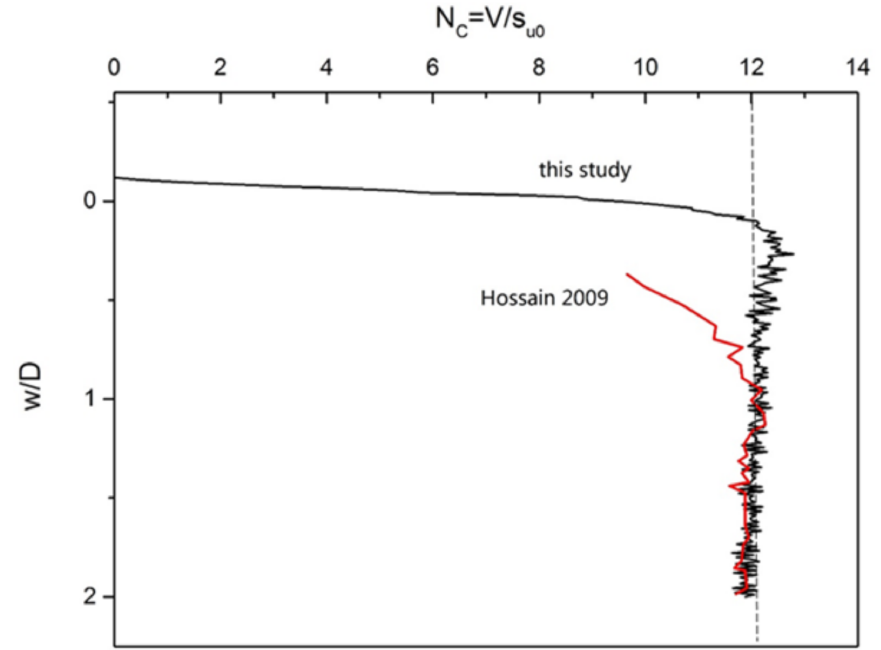
Figure 6. Bearing capacity factor of a smooth spudcan inferred from LDFE calculation with DSEL technique. ( S u 0 in the graph refers to the shear strength at the LRP (load reference point)